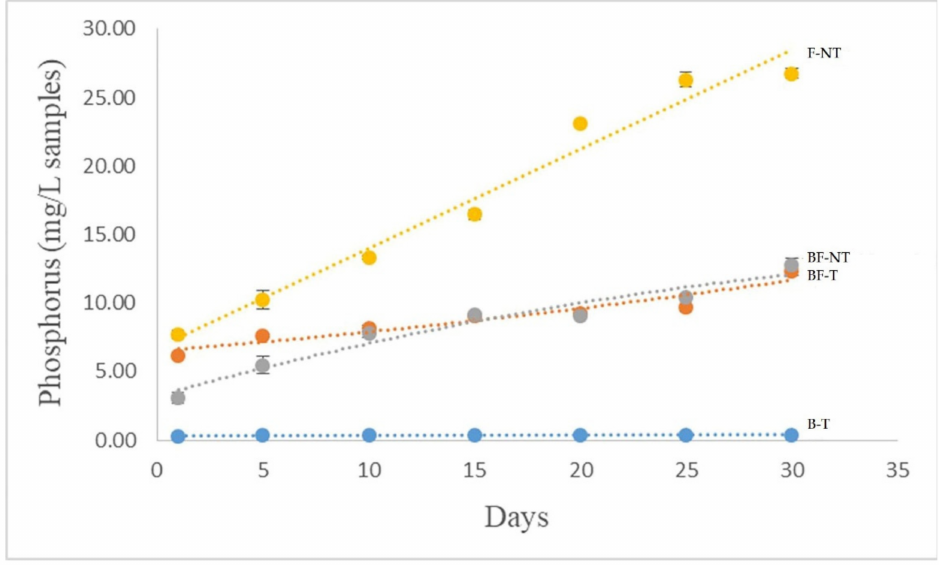
Figure 6. Phosphorus release at five day intervals for 30 days of a water incubation experiment.